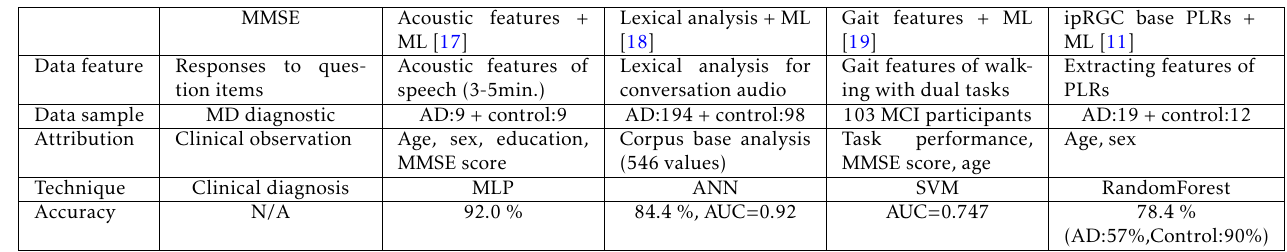
Table 1. Summary of the related